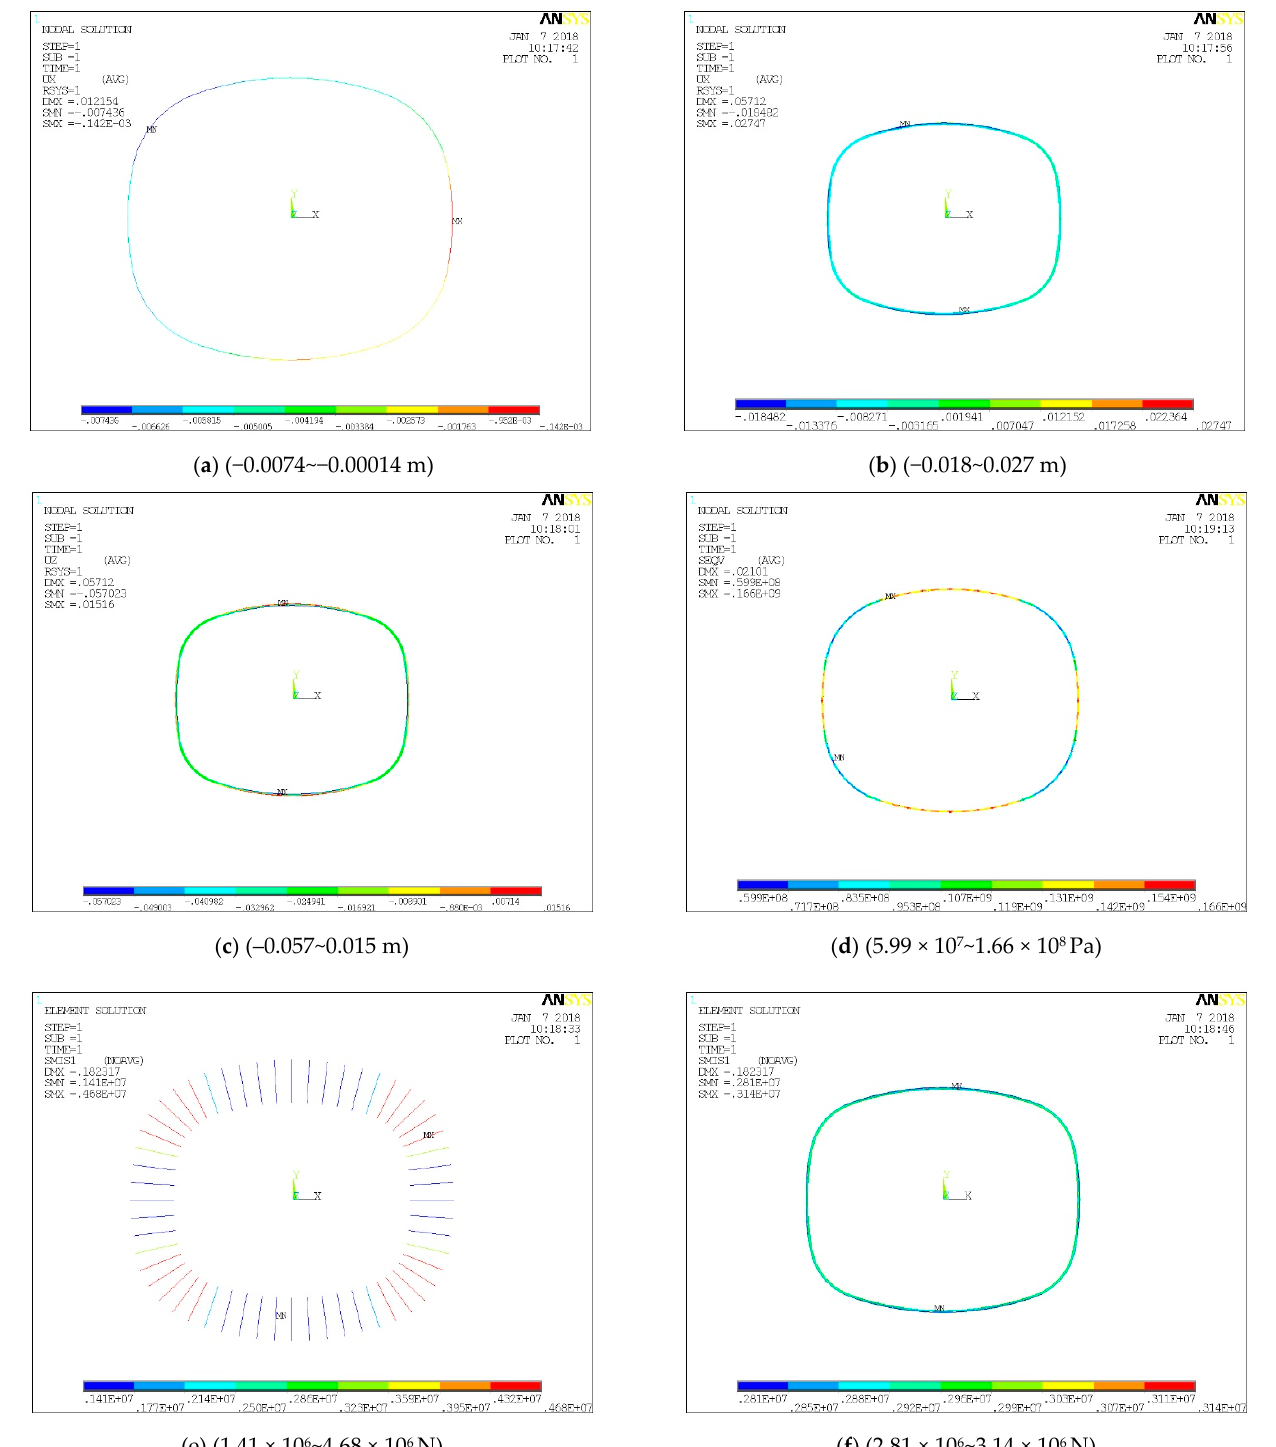
Figure 9. ANSYS calculation results: ( a ) radial displacement of CR (m); ( b ) radial displacement of